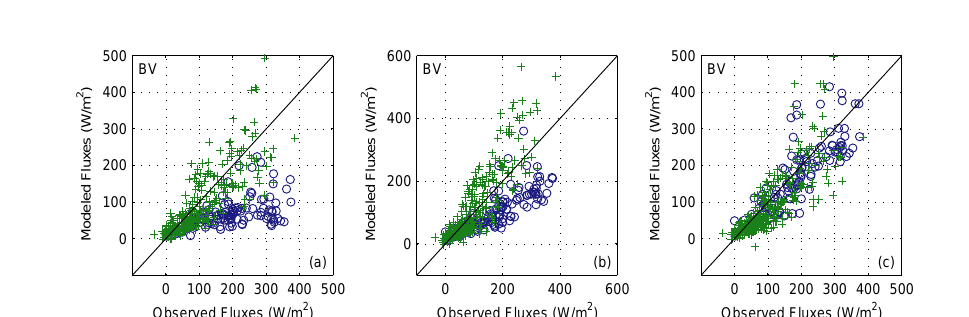
Fig. 4. Fraction of vegetation canopy that is green during the growing season at an agricultural site, BV. Solid line from field observations of LAI, broken line estimated using the VI method.